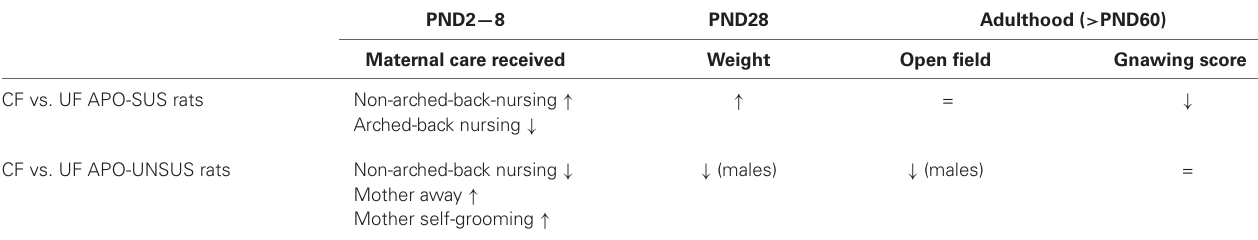
Table 1 | Overview of the results from the cross-fostering experiments with APO-SUS and APO-UNSUS rats